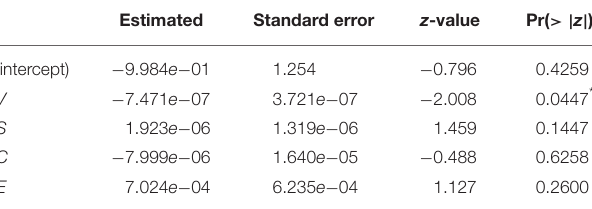
TABLE 5 | Coefficients of determination matrix.